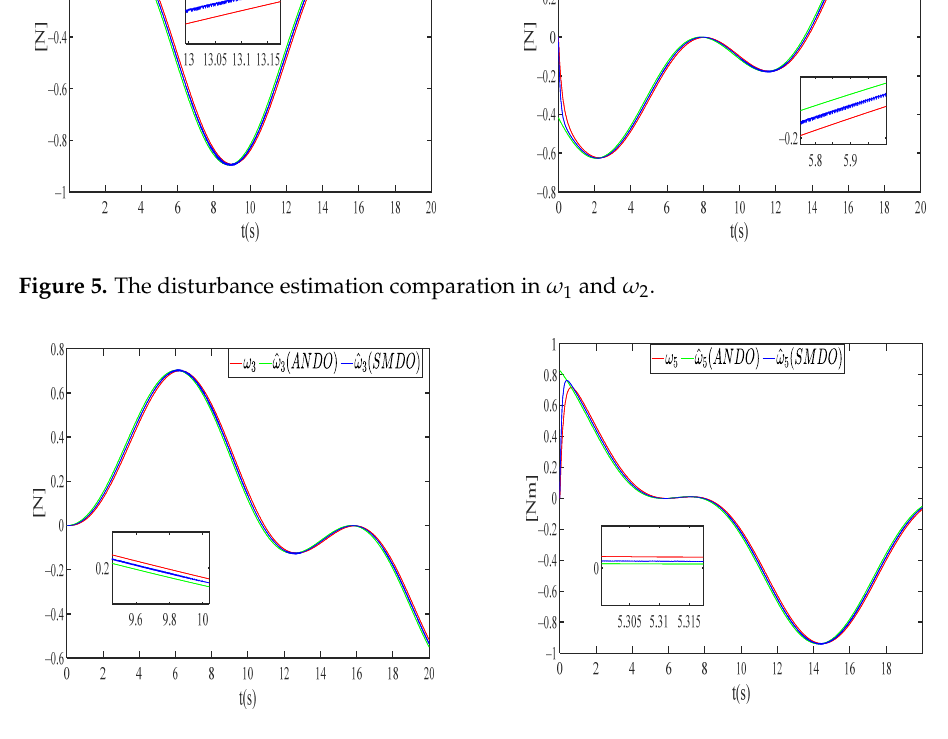
Figure 6. The disturbance estimation comparation in